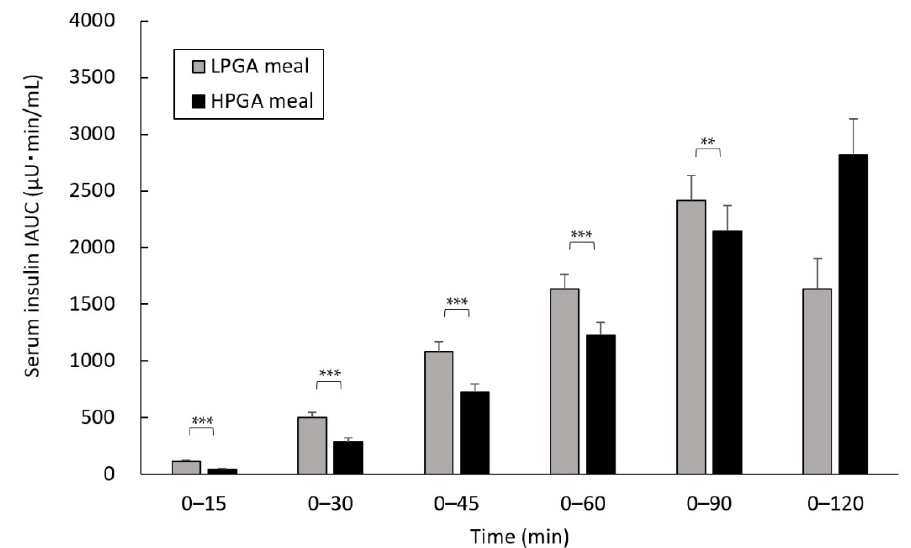
Figure 4. Effects of LPGA and HPGA meals on the levels of serum insulin IAUC. Linear mixed model analysis was used to compare the serum insulin IAUC at each time point, with the test meals (LPGA and HPGA meals) and groups as fixed effects. These data are presented as the est. mean ± SE. ** p < 0.01, *** p < 0.001. LPGA: low-gamma-polyglutamic acid; HPGA: high-gamma-polyglutamic acid;